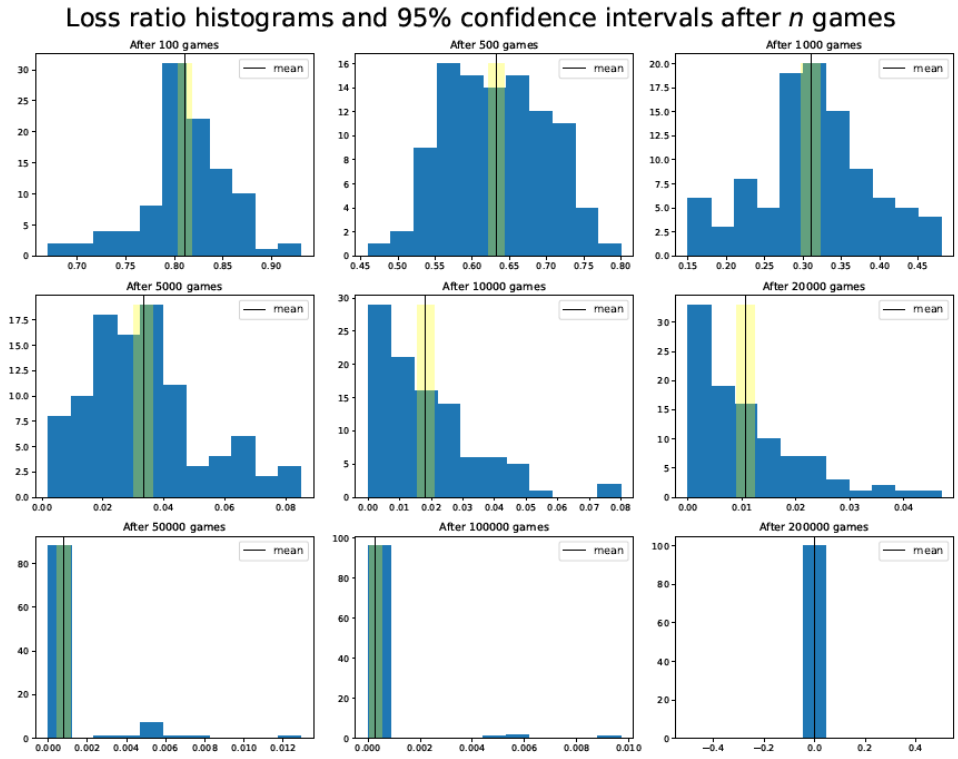
Figure 4. Tic-tac-toe TD agent loss ratio distribution histograms and 95% confidence intervals after a specific number of training games (100, 500, 1000, 5000, 10,000, 20,000, 50,000, 100,000, and 200,000) have been played against the Attack–Defense player.